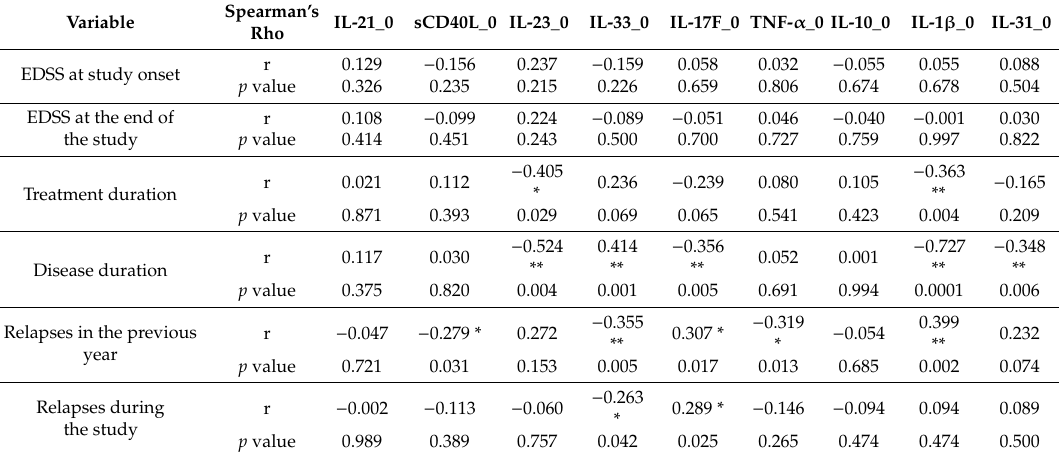
Table 2. Correlations between serum cytokine values and clinical parameters. (Spearman correlation).